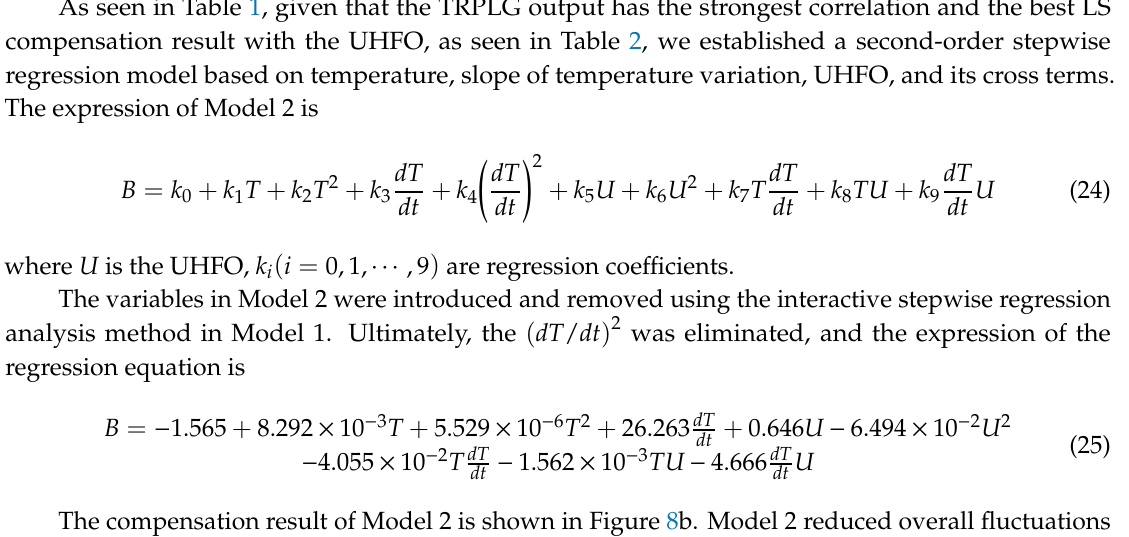
Figure 8. TRPLG bias compensation based on stepwise regression model: ( a ) Results of Model 1; ( b ) Results of Model 2. Table 3. TRPLG bias stability for compensated data based on two stepwise regression models.